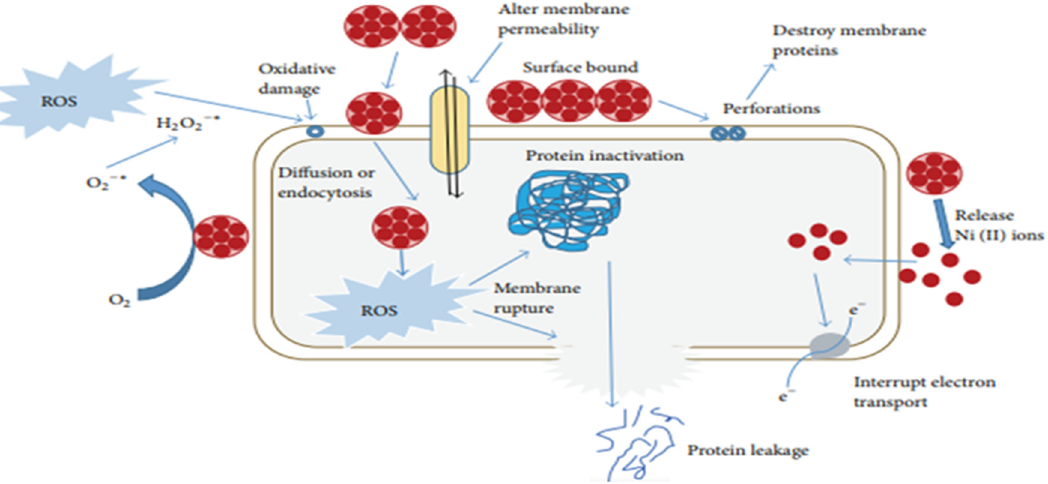
Figure 8: The mechanism of reaction for NiNP formation [ 74 ]